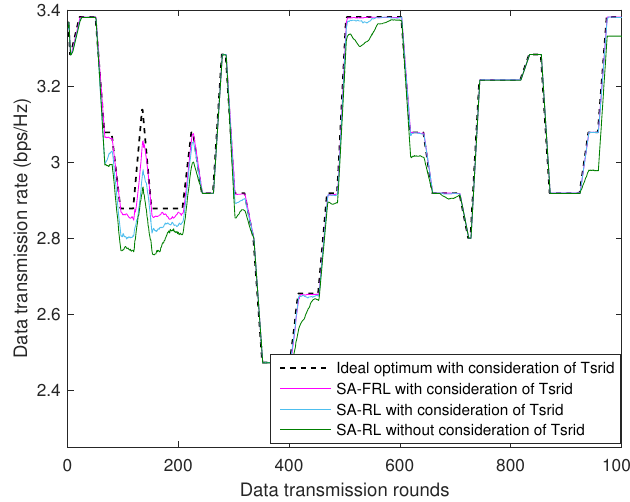
Figure 14. Data transmission rate, experimental